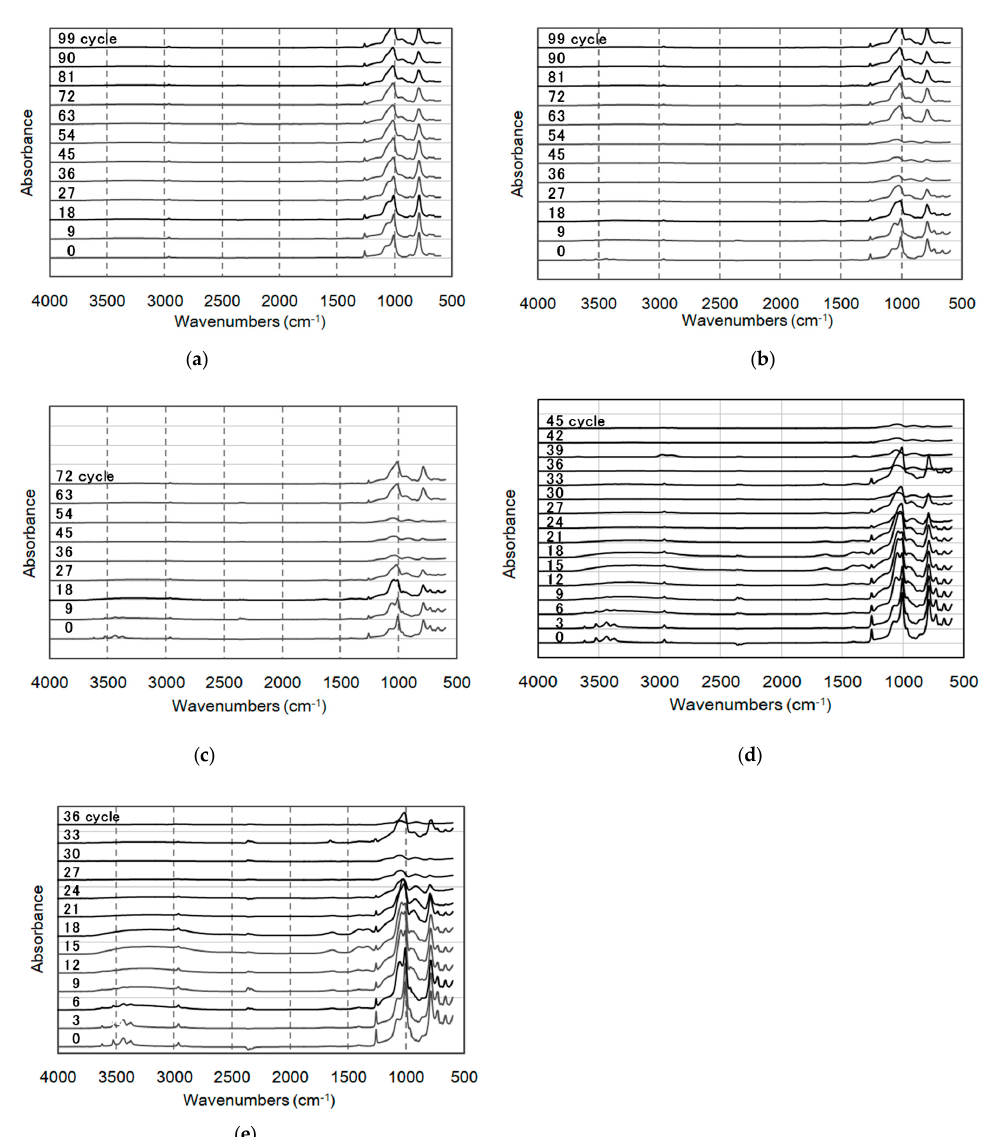
Figure 11. Change in FTIR spectra with the number of cycle obtained in the 100-cycle test with 2 mm air gap. ( a ) Sample A; ( b ) Sample B; ( c ) Sample C; ( d ) Sample D; ( e ) Sample E.